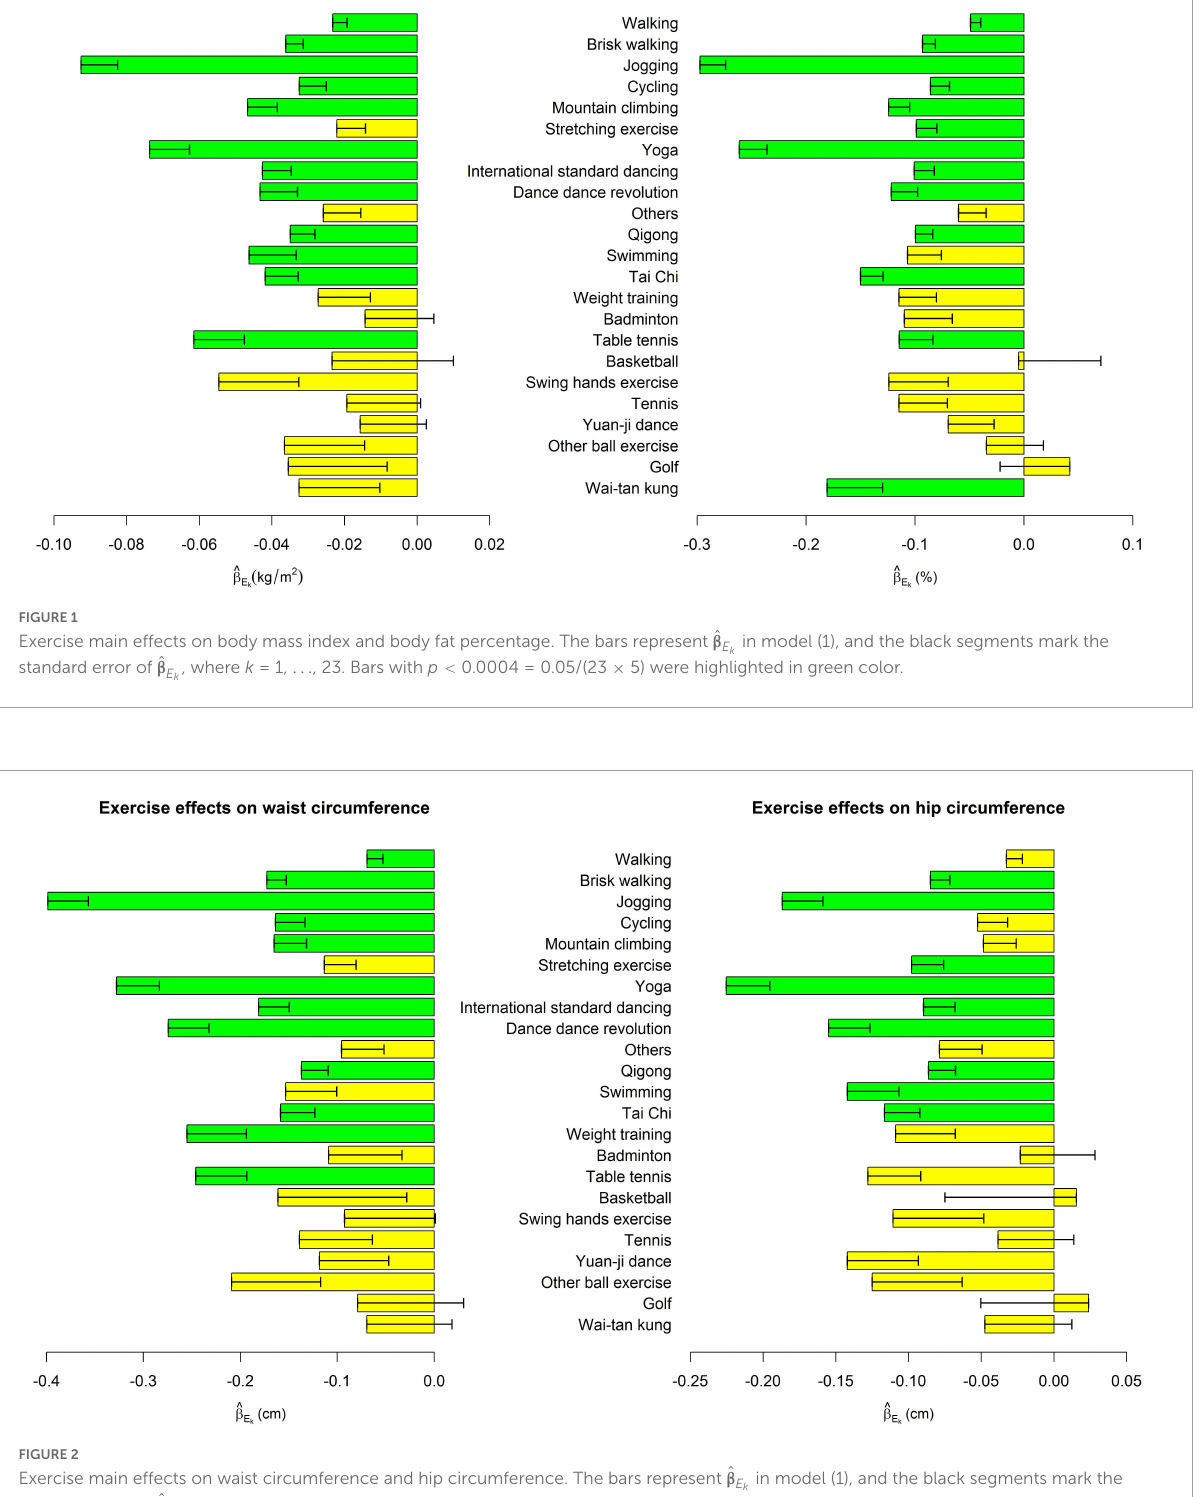
in model (1), and the black segments mark the k